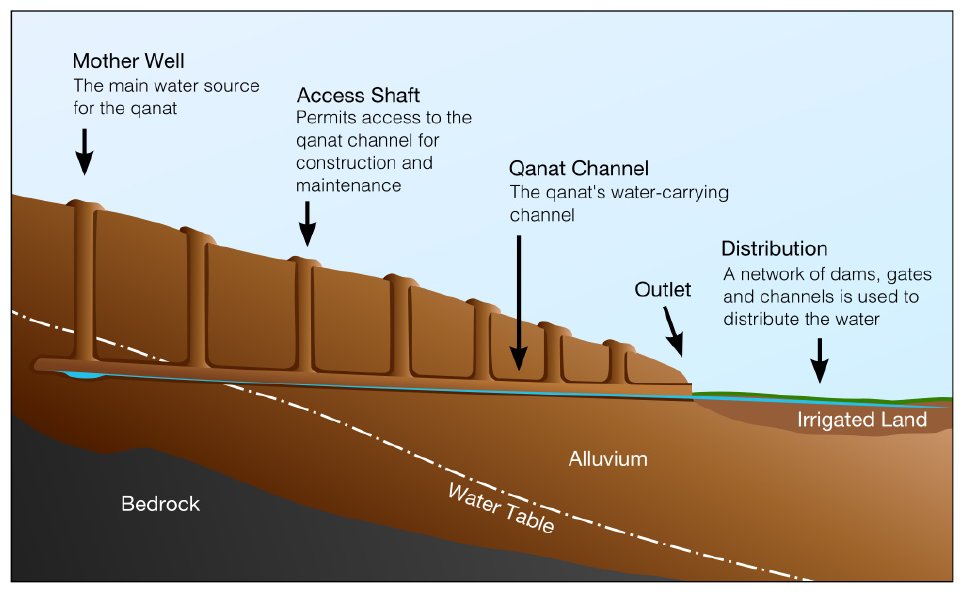
Figure 2. Cross section of a typical qanat (image from the Wikimedia Commons, author: Samuel